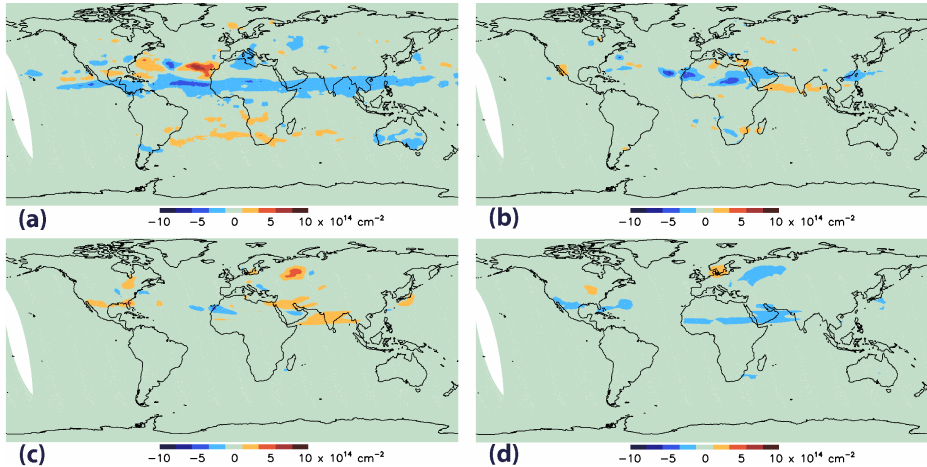
Fig. 6. Differences (=modified – nominal) in stratospheric field resulting from changes in masking threshold (nominal=0.3 × 10 15 cm − 2 ) and interpolation window dimensions (see text) in the STS algorithm. (a) Tropospheric masking threshold decreased to 0.2 × 10 15 cm − 2 . (b) Masking threshold increased to 0.4 × 10 15 cm − 2 . (c) Interpolation window halved in latitude and longitude width relative to nominal size. (d) Interpolation window doubled in